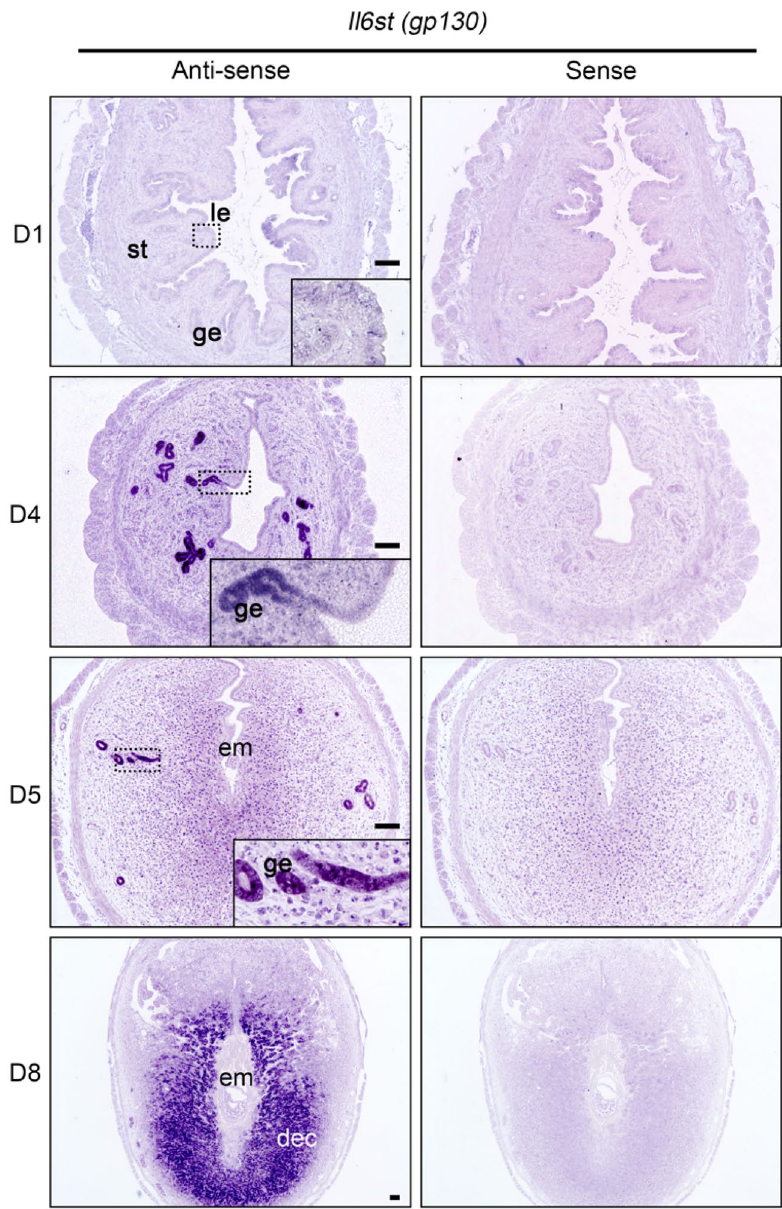
Figure 1. Spatiotemporal expression of Il6st ( Gp130 ) mRNA in the mouse uterus during early pregnancy. Signals (dark purple) are detected by an anti-sense probe (left). The sense probe (right) shows the background signal. Gp130 mRNA, which was almost undetectable at day 1 of pregnancy (D1), is expressed in the glandular epithelium (ge), but not in the luminal epithelium (le), before embryo implantation (D4), and subsequently is expressed in differentiating stromal cells and decidual cells (D5 and D8). Scale bar, 100 µm. le luminal epithelium, ge glandular epithelium, st stroma, em embryo, dec